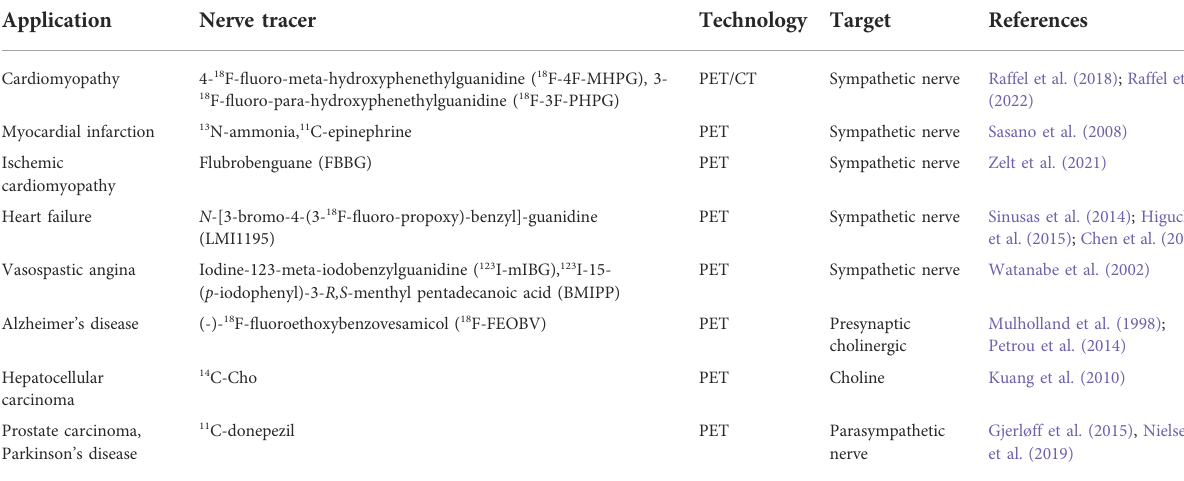
TABLE 3 The targeted molecular tracers currently used clinically in autonomic nervous system